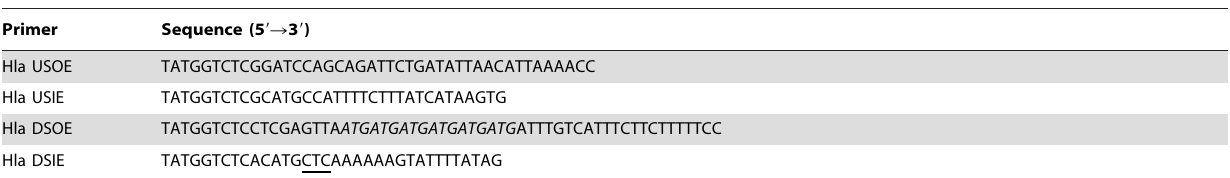
Table 1. Primers used in this